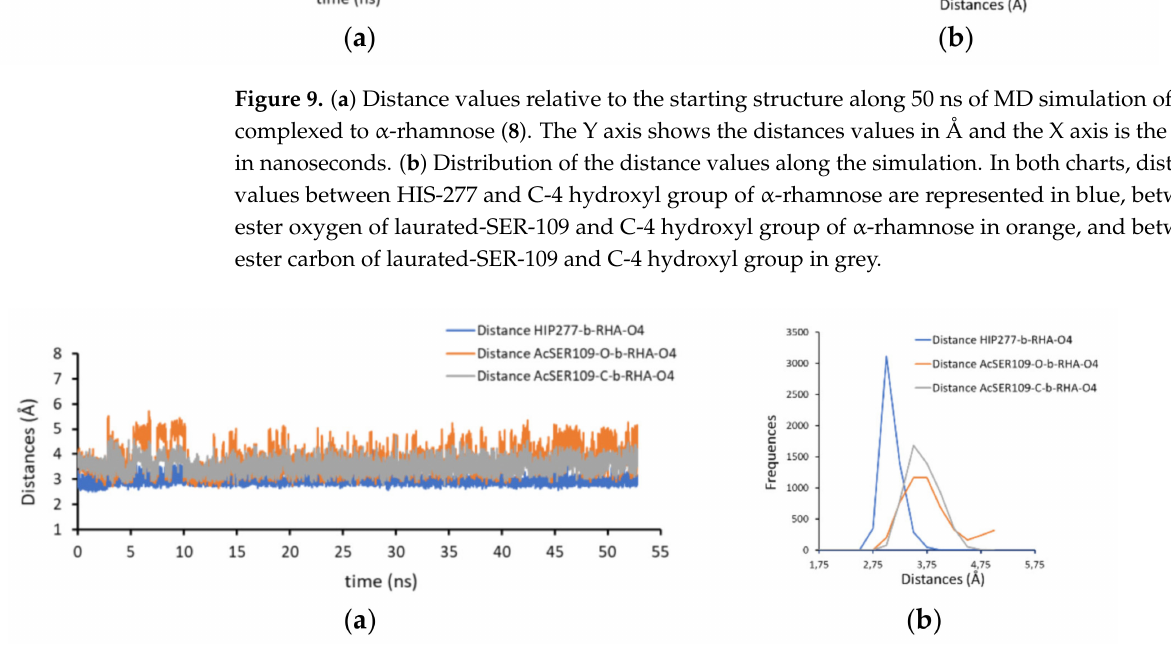
Figure 10. ( a ) Distance values relative to the starting structure along 50 ns of MD simulation of PSL complexed to β -rhamnose ( 9 ). The Y axis shows the distances values in Å and the X axis is the time in nanoseconds. ( b ) Distribution of the distance values along the simulation. In both charts, distance values between HIS-277 and C-4 hydroxyl group of α -rhamnose are represented in blue, between ester oxygen of laurated-SER-109 and C-4 hydroxyl group of α -rhamnose in orange, and between ester carbon of laurated-SER-109 and C-4 hydroxyl group in grey.